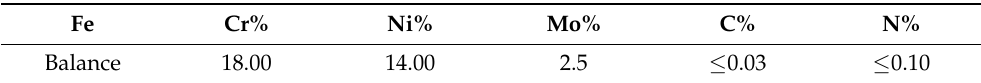
Table 1. Chemical composition of EOS 316L powder.